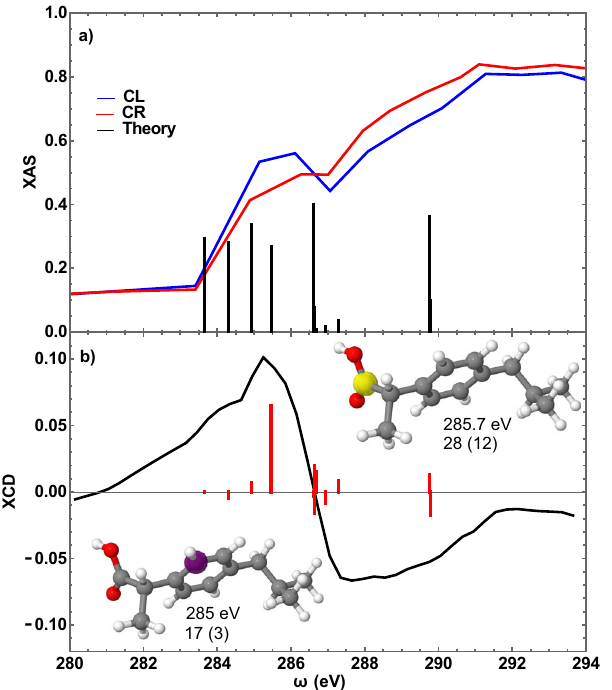
Fig. 2 | Absorption spectrum and XCD signal. a Steady-state carbon K-edge absorption spectrum of S-IBP recorded with circularly left (blue trace) and right (red trace) polarized light. The sticks represent the calculated transition energies and oscillatory strengths for the fi rst core-excited state of each of the 13 carbon atoms in the molecule. Black sticks are the transitions investigated in the present work. b Steady-state carbon K-edge X-ray circular dichroism (XCD) signal calcu- latedas the difference of the Land R spectrashown in panel a , normalized by their sum. Insets in panel b show the selected atoms by the corresponding probe wavelength and their numbering. Numbers in brackets refer to the S enantiomer.